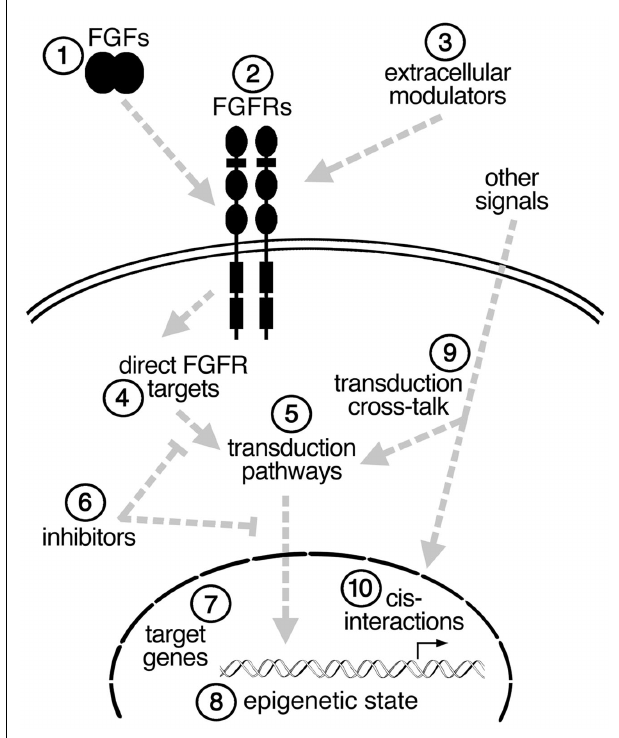
FIGURE 1 | Simplified schema illustrating some of the possible steps (1–10) at which an FGF signal could be modulated in different cell types to affect cell fate. See text for details.